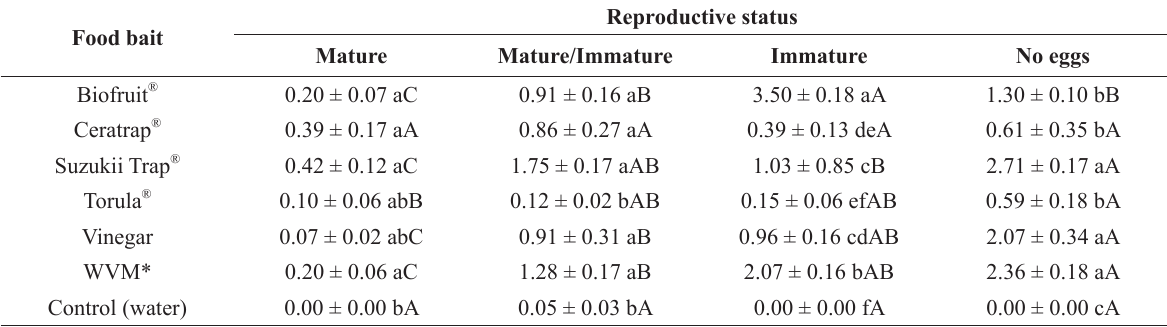
Number (mean ± standard error) of Drosophila suzukii females captured with different food baits according to their reproductive stage in a blackberry